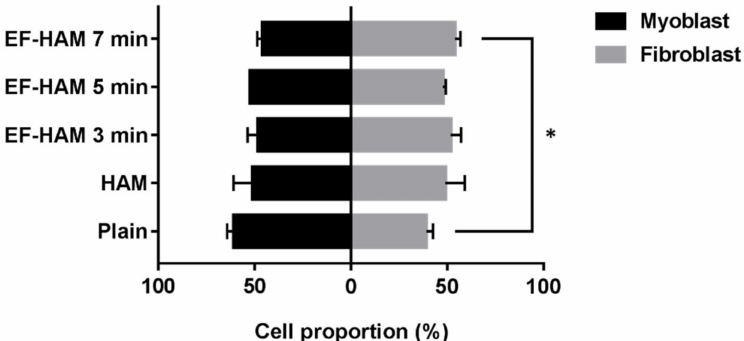
Figure 7. Proportion of skeletal myoblasts and fibroblasts growing on SkM-seeded HAM and EF- HAM scaffolds at the time of CM collection. The values are represented as mean ± SEM (* p < 0.05, compared with plain; One-way